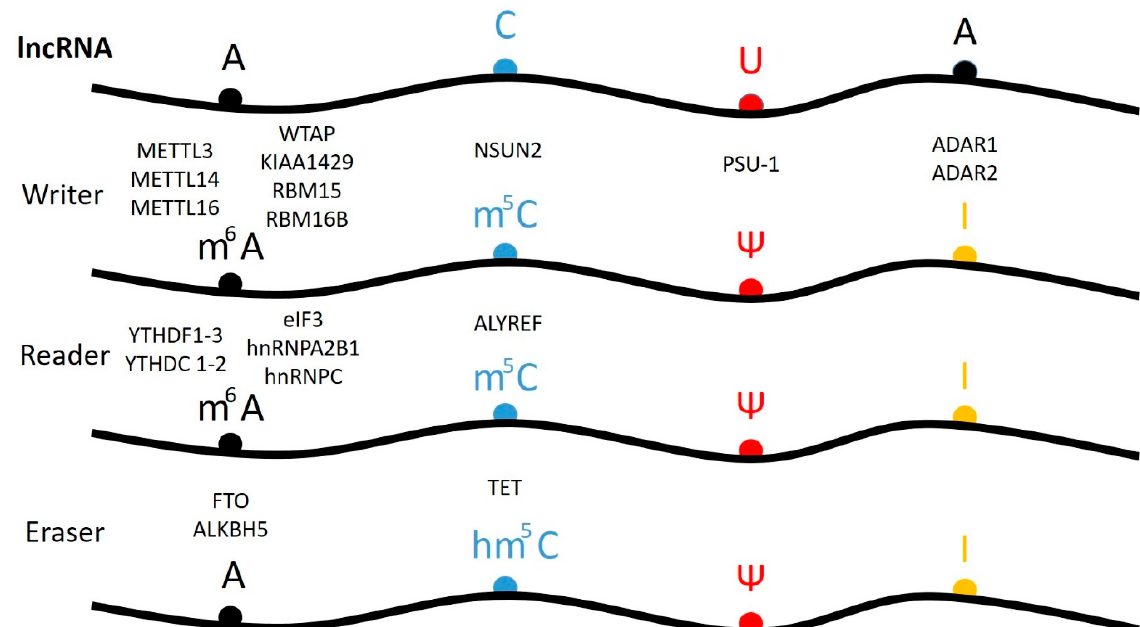
Figure 3. Schematic of lncRNA modification pathways. Writer, reader and eraser proteins are shown. Nucleotides: A—adenosine; C—cytidine;